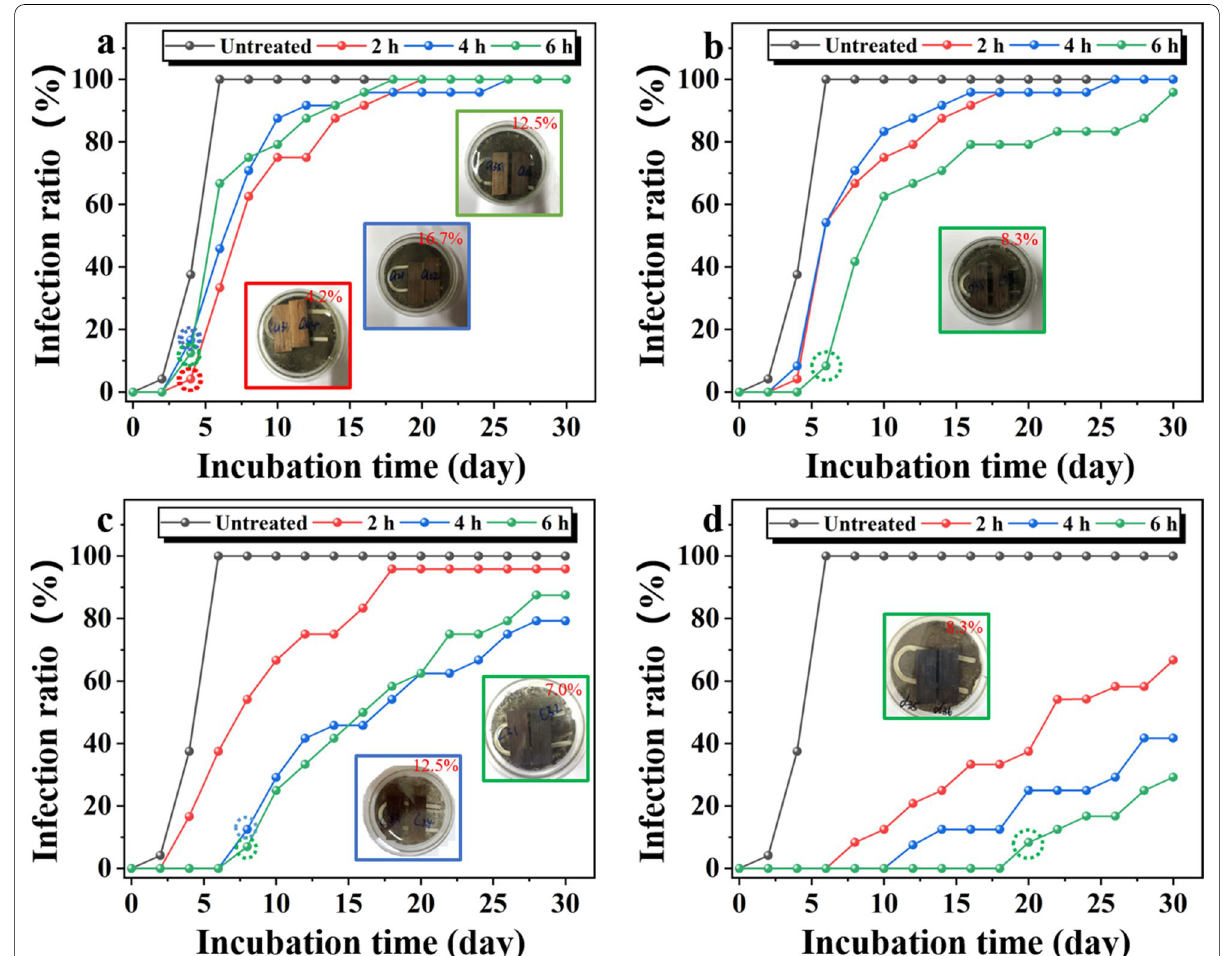
Fig. 10 The infection ratio of untreated and oil heat-treated samples with three mixed fungi: a 140 °C, b 160 °C, c 180 °C, d 200 °C